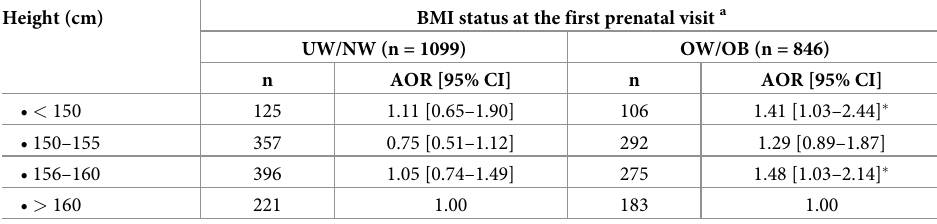
Table 4. Adjusted odds ratio (OR) and 95% confidence intervals (95% CI) for the associations between height and gestational diabetes mellitus (GDM) stratified by BMI at prenatal visit. Height